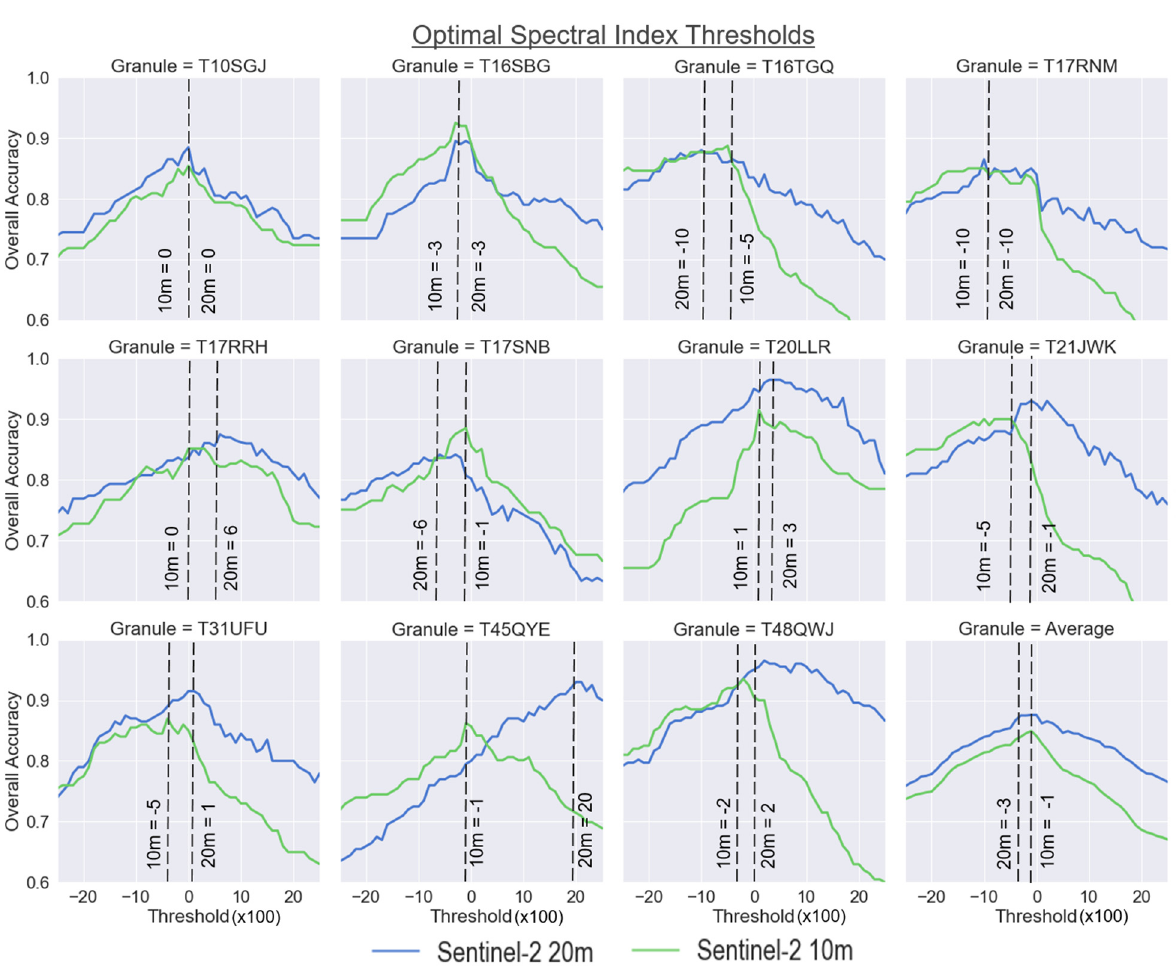
Figure 3. Evaluation of the most accurate spectral index threshold for automated training data selection for the 10 m and 20 m datasets across the test sites. For the 10 m dataset, the NDWI index is used, and for the 20 m dataset, NDWI, MNDWI, and AWEIsh are used. Overall highest accuracies (84.9% 10 m, 87.5% 20 m) are observed around –0.01 or 0 but vary by granule. Note: spectral index thresholds values are multiplied by 100 in the